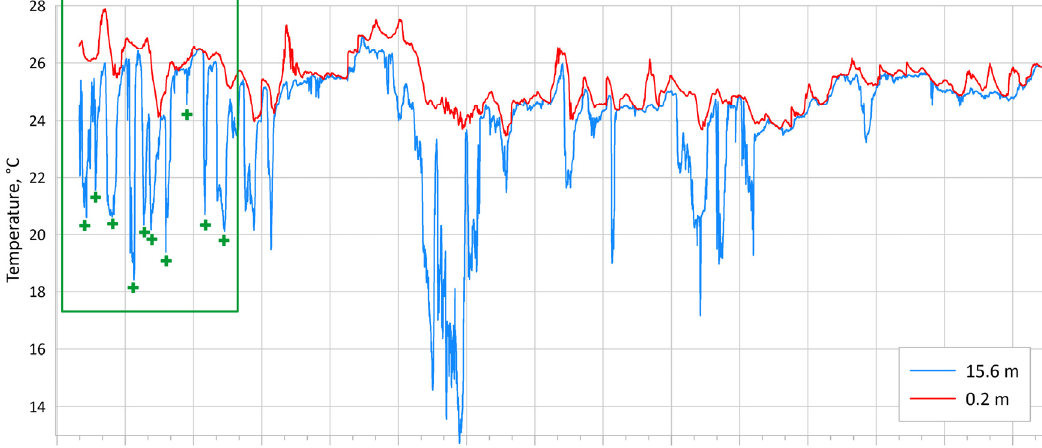
Figure 14. Water temperature at the surface (red line) and on horizon of 15.6 m (blue line) from 16 July to 29 August 2020. Examples of internal waves with period 10–20 h are marked with green crosses in the green rectangle.